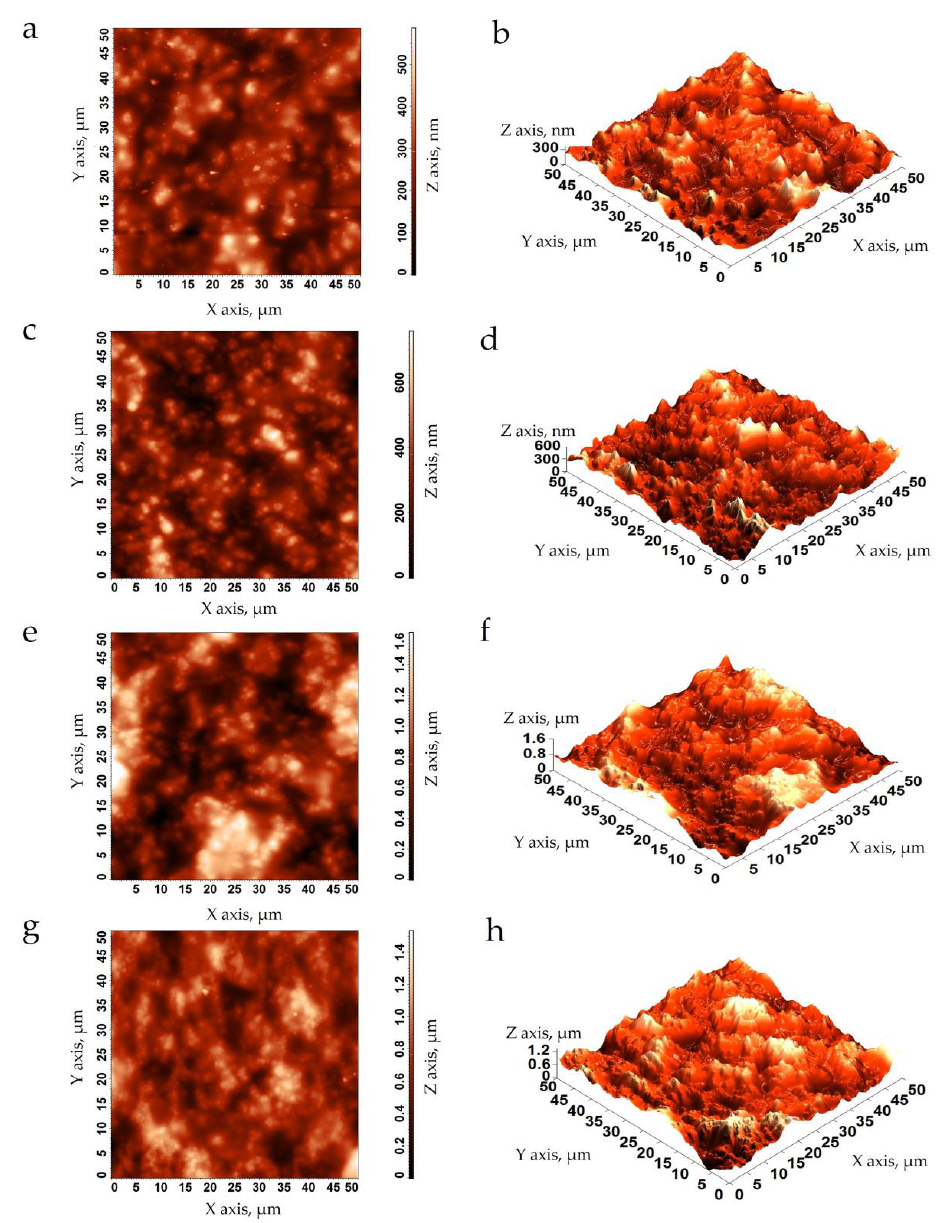
Figure 4. Atomic force micrographs of cassava starch films containing quinoa starch nanocrystals at ( w / w ): ( a , b ) 0%; ( c , d ) 2.5%; ( e , f ) 5.0% and ( g , h ) 7.5%. Left: 2D, and right: 3D micrographs.